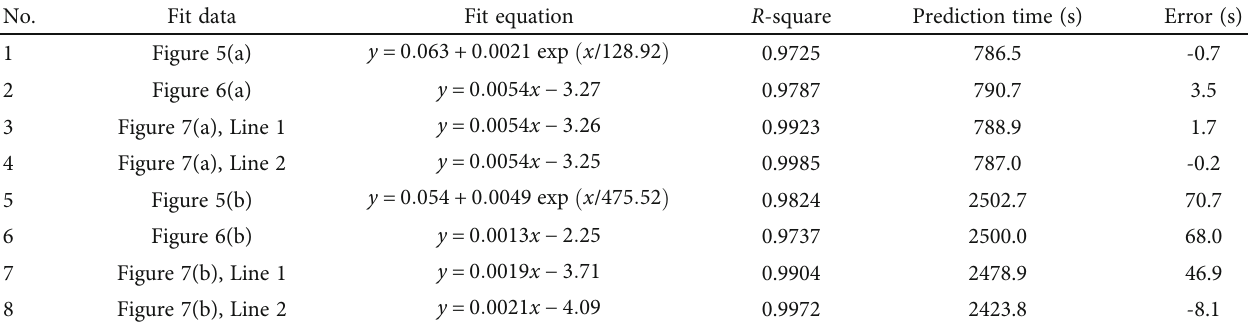
Table 1: The results of predicting time-to-failure of rocks. Nos. 1 ~ 4 are the results of specimen R1. Nos. 5 ~ 8 are the results of specimen R6. No. Fit